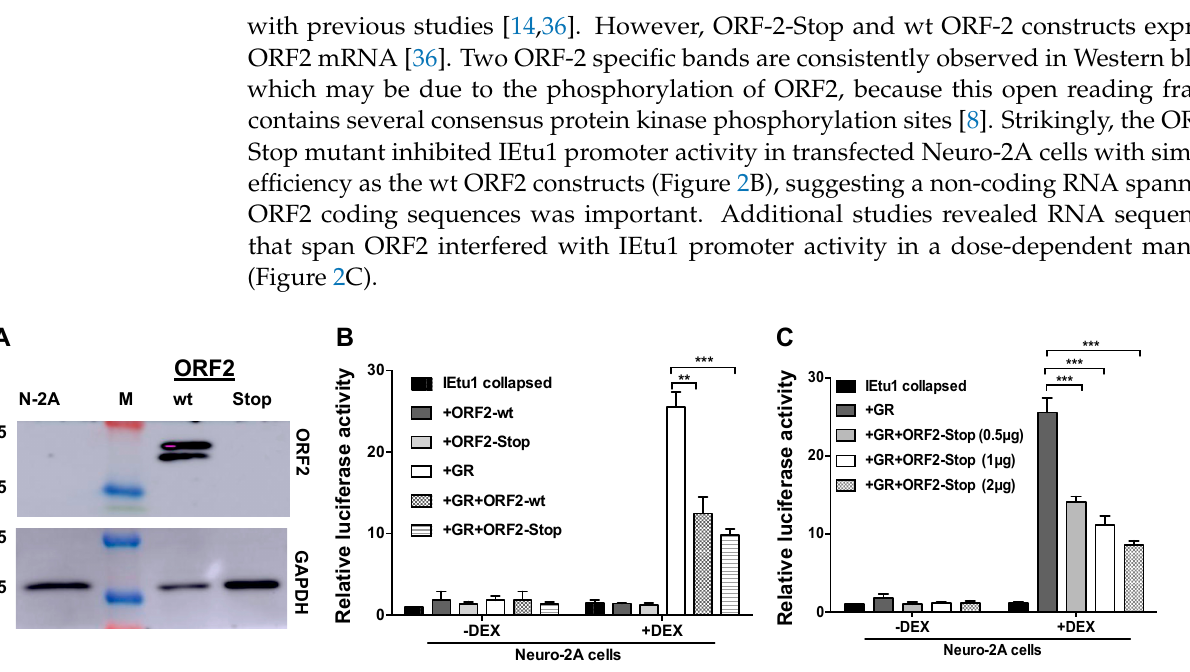
Figure 2. The construct of an ORF2 mutant that lacks the first in-frame methionine and contains stop codons at its amino-terminus (ORF2-Stop) reduced GR+DEX mediated transactivation of the immediate early transcription unit 1 (IEtu1) collapsed promoter. Panel ( A ): Neuro-2A cells were transfected with plasmids that express wt ORF2 (2.0 μ g) or ORF2-Stop construct (2.0 μ g). Forty-eight hours after transfection, whole cell lysate (WCL) was prepared and processed for Western blot analysis using a Flag-specific antibody to detect ORF2 or a GAPDH-specific antibody. Each lane contained 10 μ g protein from WCL. GAPDH was measure as a loading control. Position of molecular weight markers are shown. Panel ( B ): Neuro-2A cells were transfected with the IEtu1 collapsed promoter construct (0.5 μ g), GR (1.0 μ g), wt ORF2 (1.0 μ g), or ORF2-Stop construct (1.0 μ g). Panel ( C ): Neuro-2A cells were transfected with the IEtu1 collapsed promoter construct (0.5 μ g), GR (1.0 μ g), and ORF2-Stop construct (0.5, 1.0, or 2.0 μ g). Panels B and C: all transfections contained a plasmid that expresses Renilla luciferase (0.05 μ g). To maintain the same amount of DNA in each sample, an empty vector was included in certain samples. Cells were incubated with 2% stripped FBS 24 h after transfection, and certain cultures were treated with DEX (10 μ M). At 48 h after transfection, cells were harvested, and protein lysate was subjected to a dual-luciferase assay. The results are the average of three independent experiments, and error bars denote the standard error. The Student’s T test was used for statistical analysis: **, p < 0.01; ***, p < 0.001.